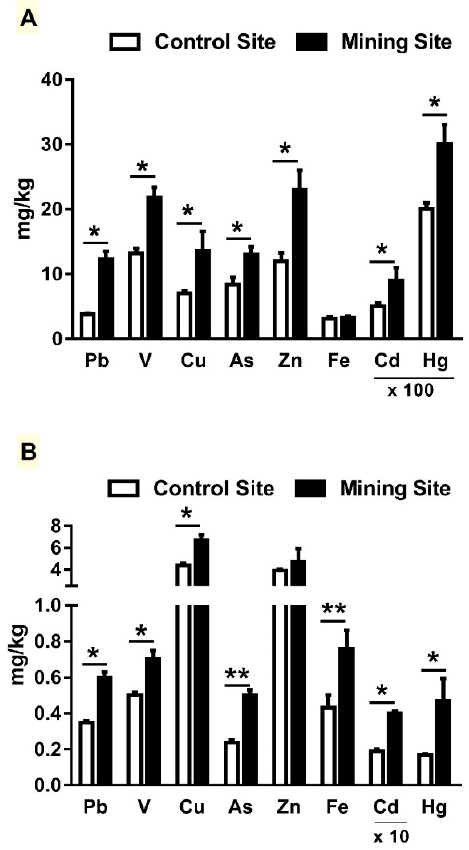
Figure 2. Concentration of heavy metals in ( A ) soil and ( B ) L. shawii from the mining and control sites. Data are means ± SEM, ( n = 8). * p < 0.05 and ** p < 0.01.